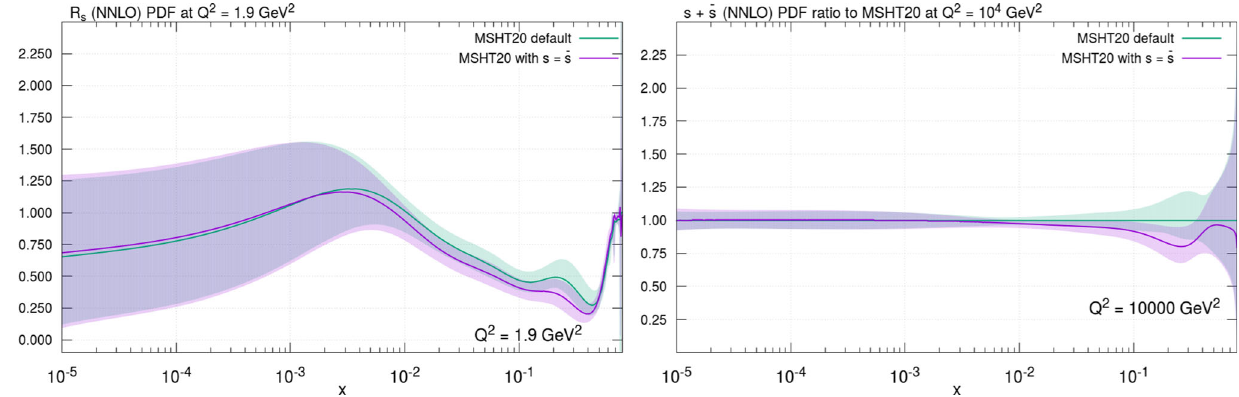
Fig. 71 The total strangeness at NNLO when s = ¯ s is enforced at the input scale in the global fit. (Left) the values of R s at Q 2 = 1 . 9 GeV 2 compared to the MSHT20 default fit. (Right) the ratio of the s + ¯ s at Q 2 = 10 4 GeV 2